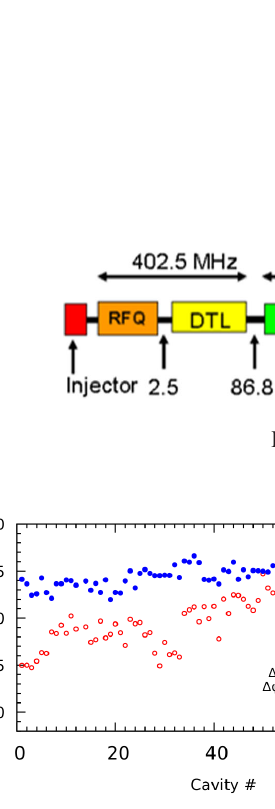
FIG. 2. Typical distributions of the SCL cavity energy gains (left-hand-side vertical axis) and synchronous phases (right-hand- side vertical axis).